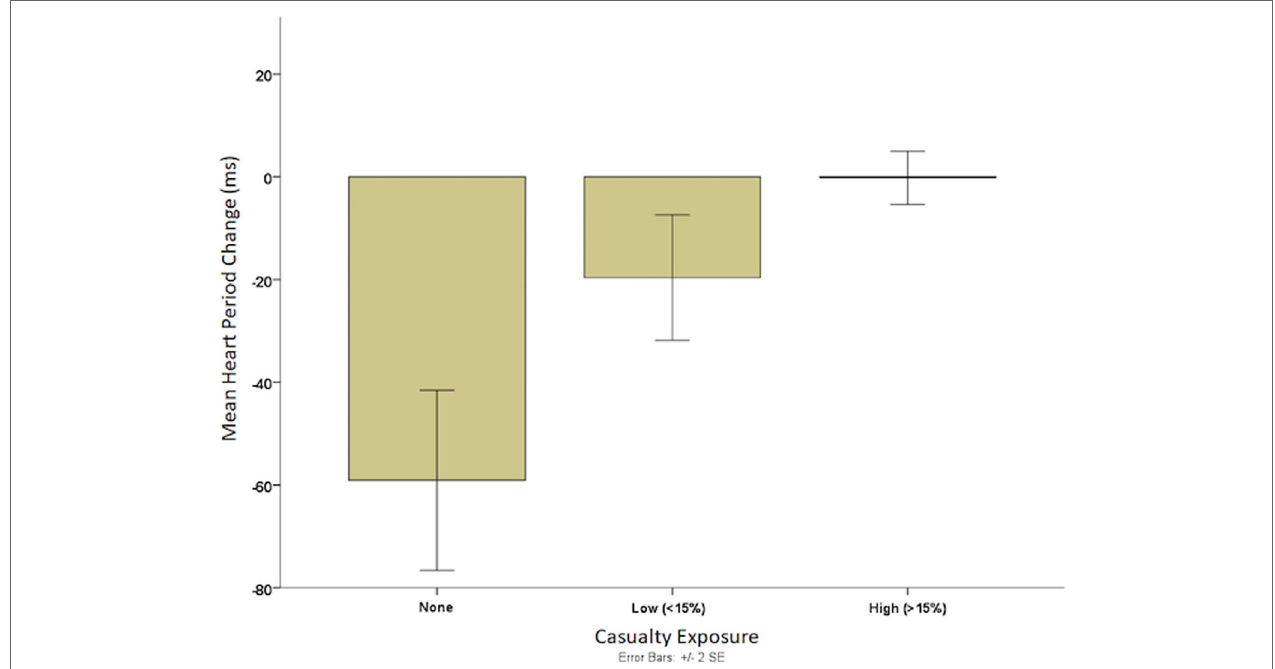
FigUre 6 | Mean heart period (HP) change during Soldier Performance and Effective, Adaptable Response (SPEAR) task and rates of casualty exposure. A three-group classification derived from the self-reported rates of exposure to combat casualties (1 = none; 2 = 1–15%; 3 = > 15%) is illustrated. The HP value is the change in HP during the SPEAR task. These results illustrate that higher rates of casualty exposure leads to significantly diminished flexibility in cardiac response (less of a saw tooth HP pattern) during SPEAR task